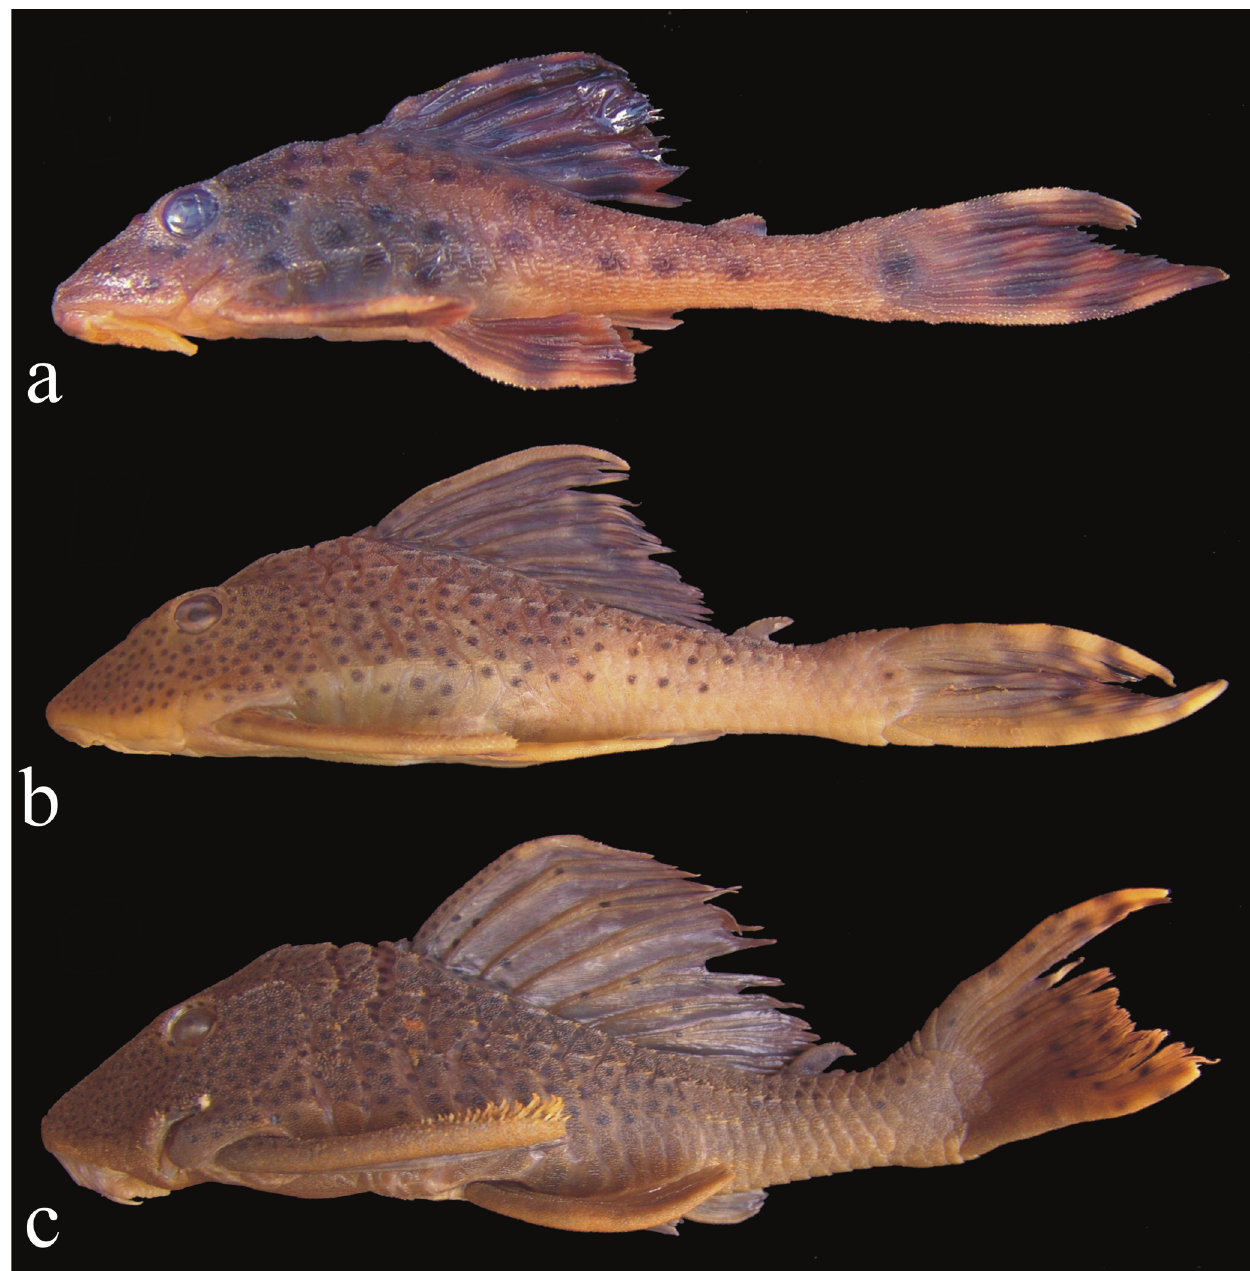
Fig. 2. Specimens of Hypostomus dardanelos showing ontogenetic variation on the color pattern and on the development of the nuptial body odontodes in c. (a) NUP 7098, paratype, 46.0 mm SL; (b) NUP 6759, paratype, 115.5 mm SL; and (c) NUP 7474, paratype, 181.0 mm